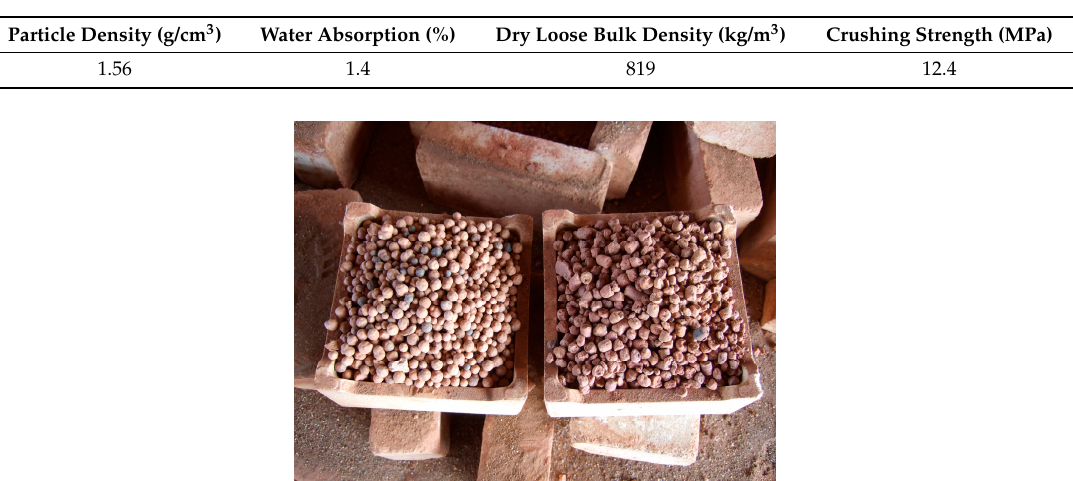
Figure 8. The sintered LWAs using the commercial tunnel kiln. Table 17. Test results for high performance LWAs produced by the commercial tunnel kiln. Particle Density (g/cm 3 )